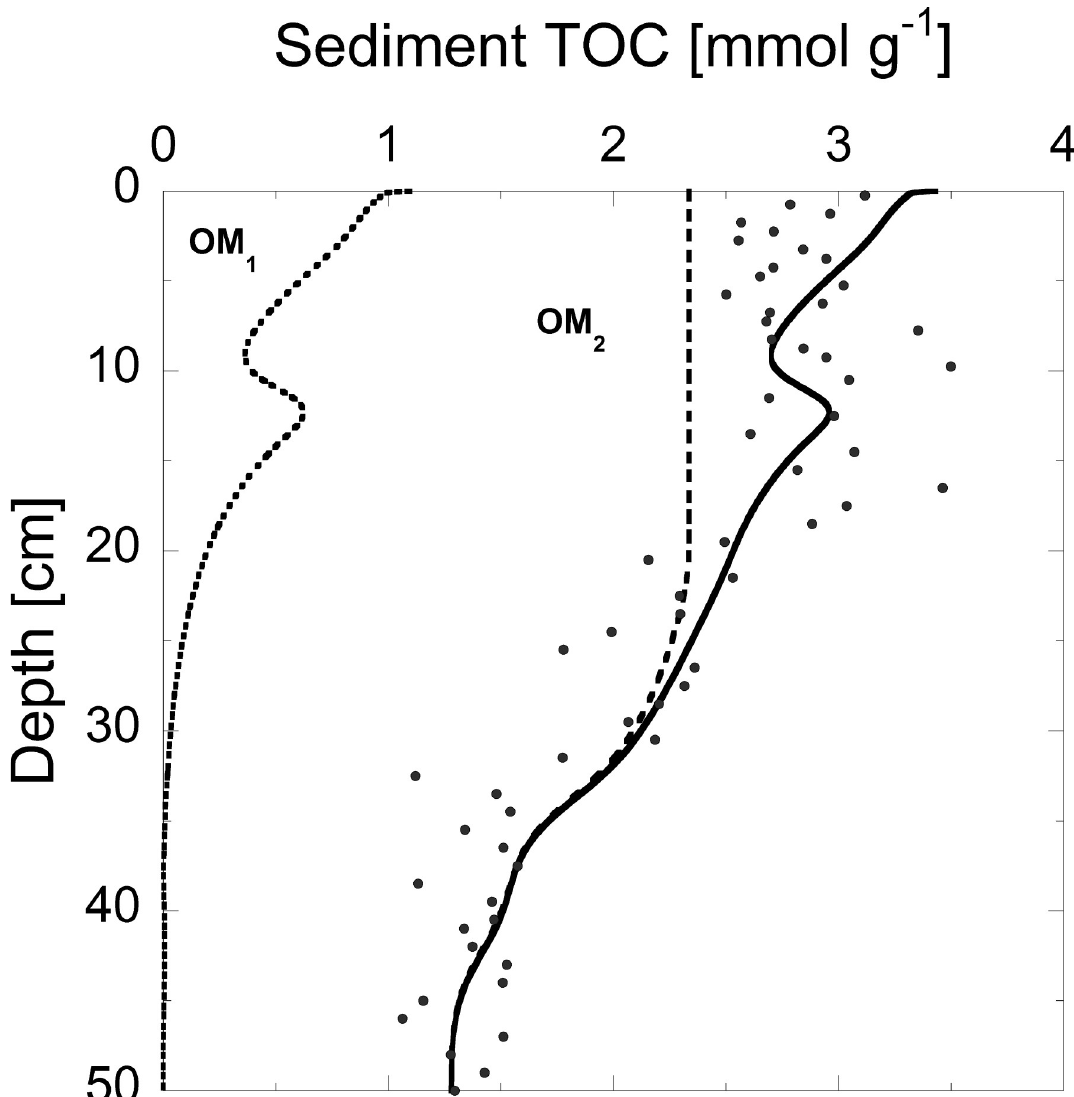
Fig 4. Vertical profiles of measured (dots) and simulated (line) TOC concentrations (2015). Simulated concentrations are further split up into reactive OM 1 (dotted) and non-reactive OM 2 (dashed) TOC pools. The “bump” in the modeled TOC concentration between 10 and 15 cm depth is caused by the onset of artificial aeration in